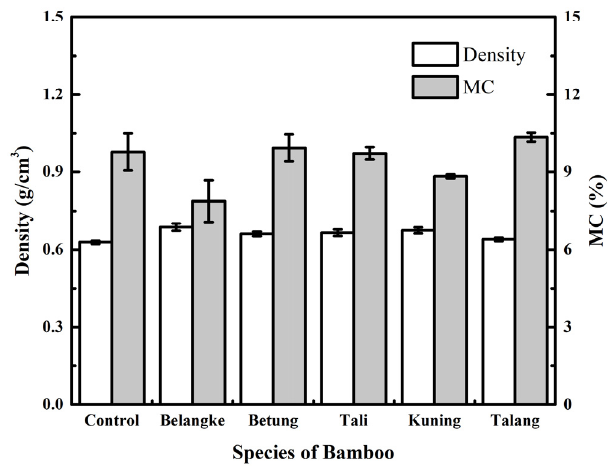
Figure 2. Density and moisture content (MC) of